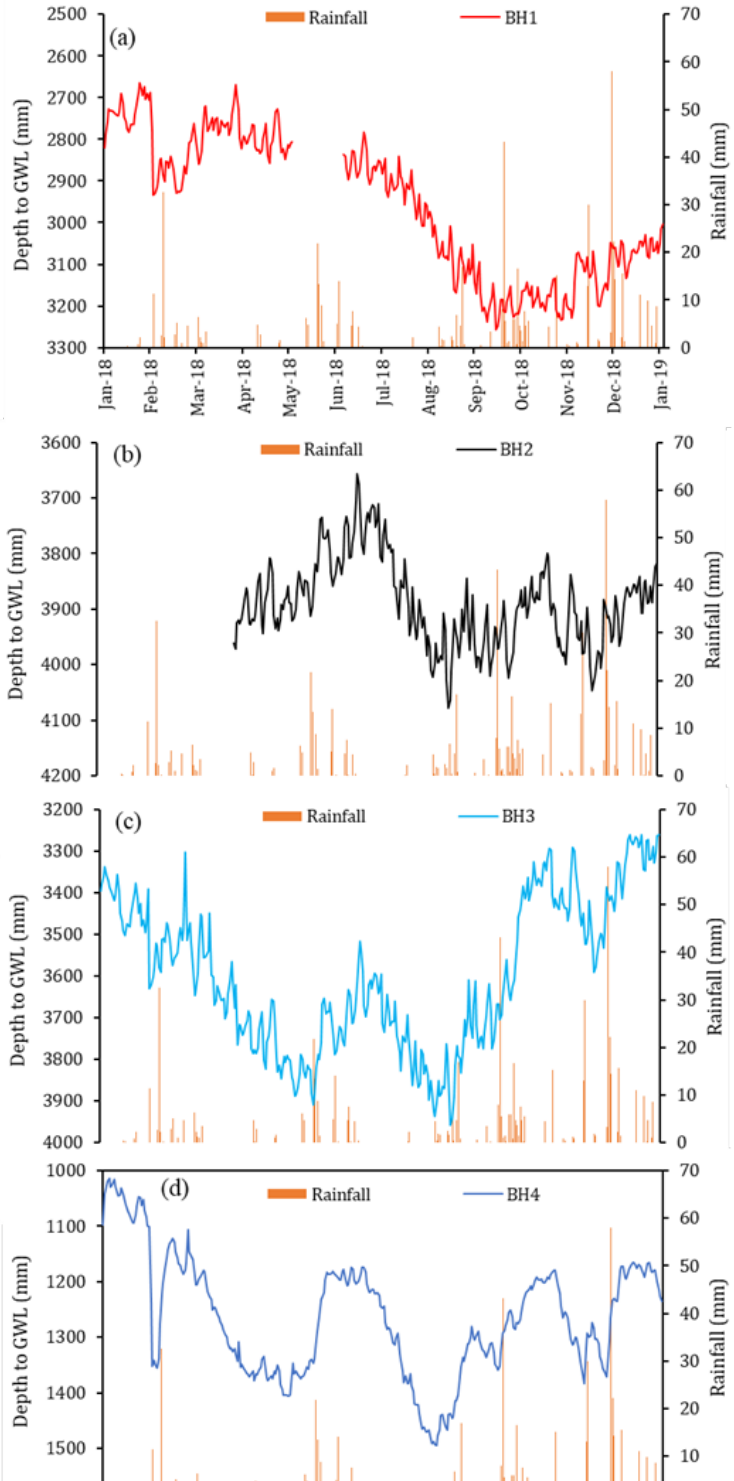
Figure 3. Daily rainfall and daily groundwater-level data for ( a ) BH1 ( b ) BH2 ( c ) BH3 ( d ) BH4.